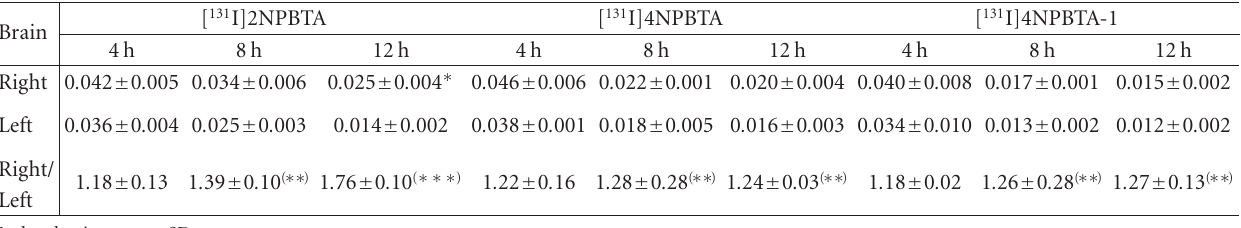
Table 2: Uptake in the gerbil ischemic and normal brain hemisphere